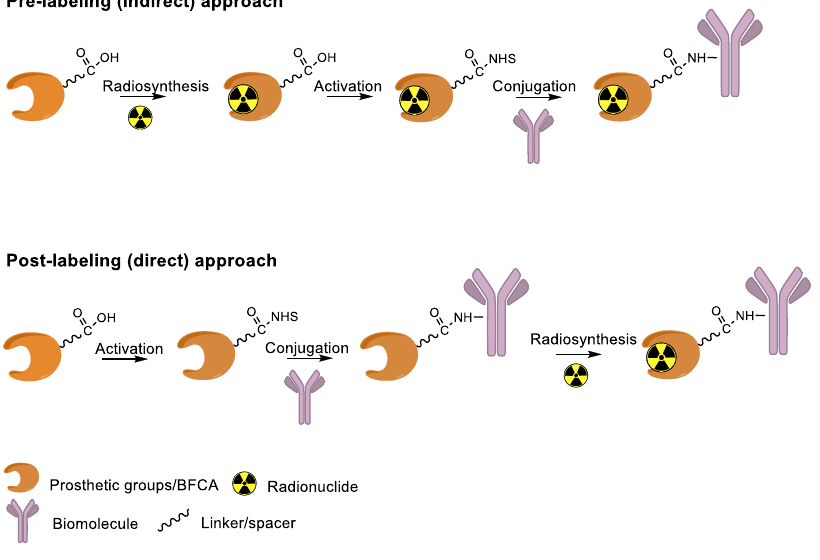
Figure 1. Radiolabeling approaches.